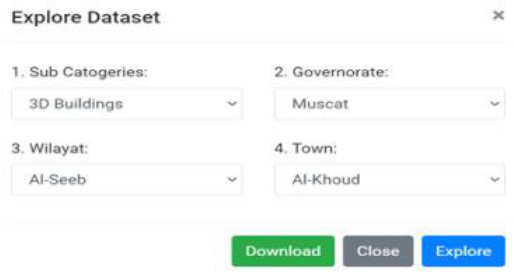
Figure 6 . The explore function in the developed geoportal.